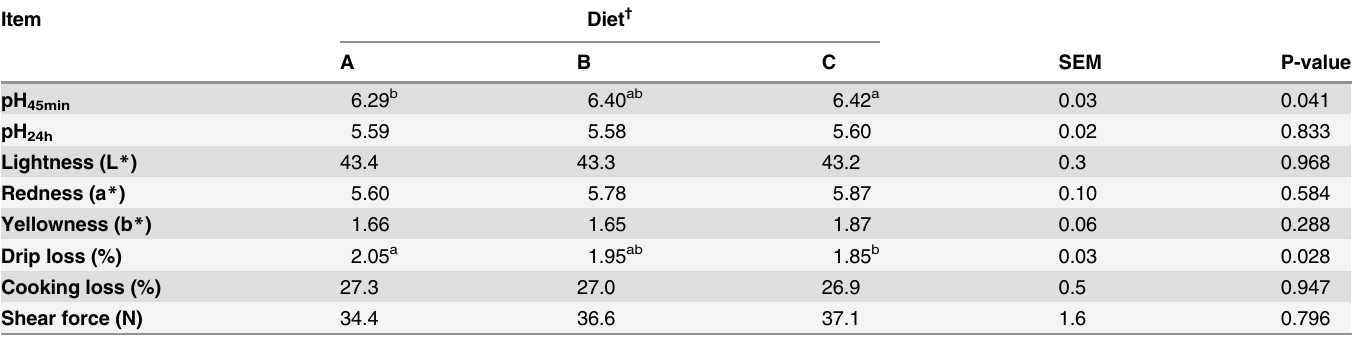
Table 6. Effect of dietary energy sources on M. longissimus lumborum meat quality of finishing pigs.